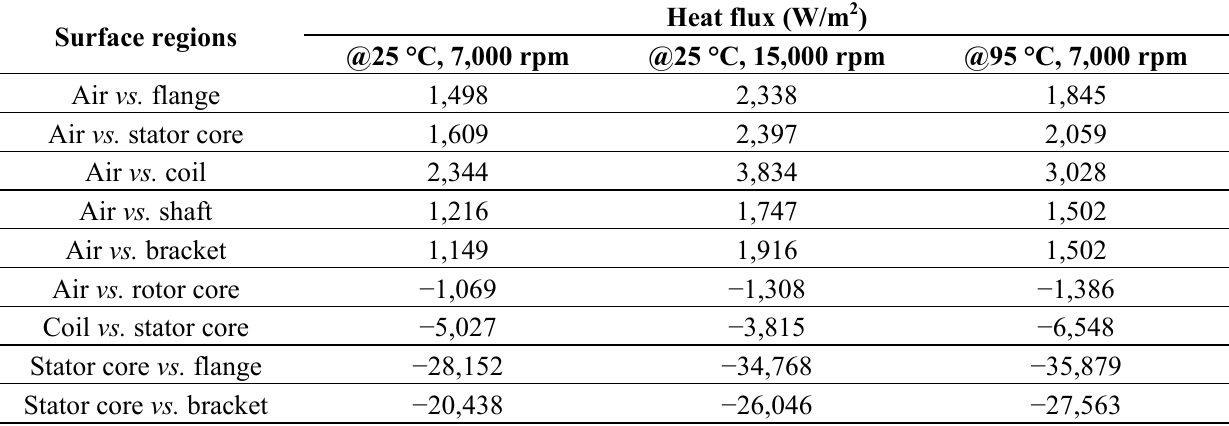
Table 5. Heat flux of motor surface regions at different motor speeds and ambient temperatures. Surface